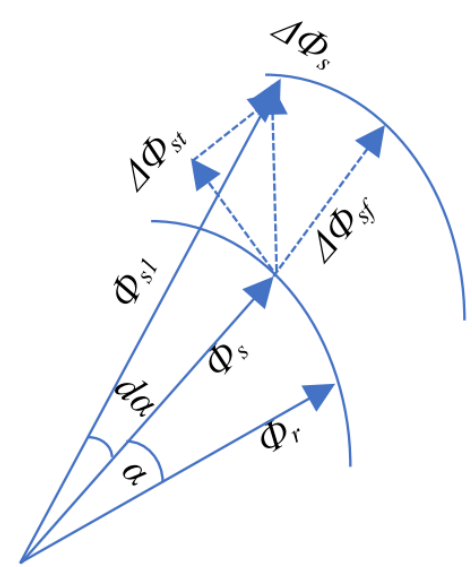
Figure 5. Flux linkage vector variation.